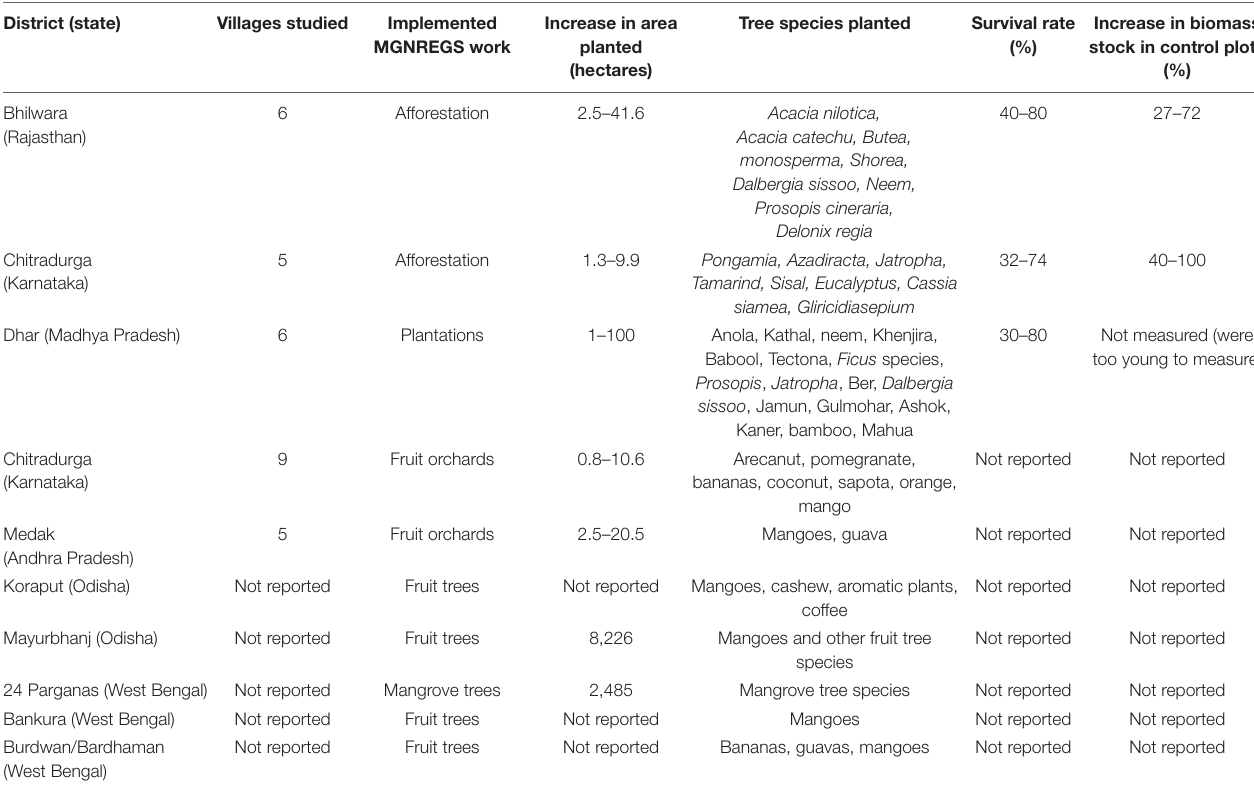
TABLE 1 | Impact of MGNREGS on the forests, plantations, and fruit orchards in some states of India. District